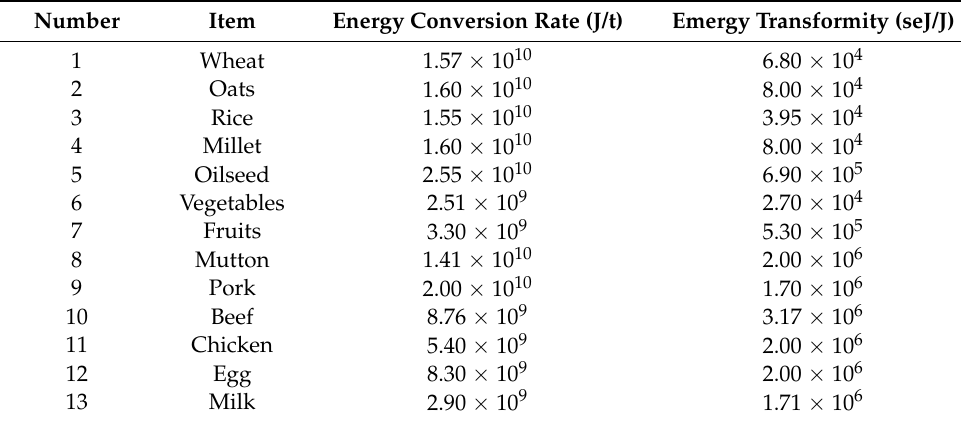
Table 2. Conversion rates of different food items